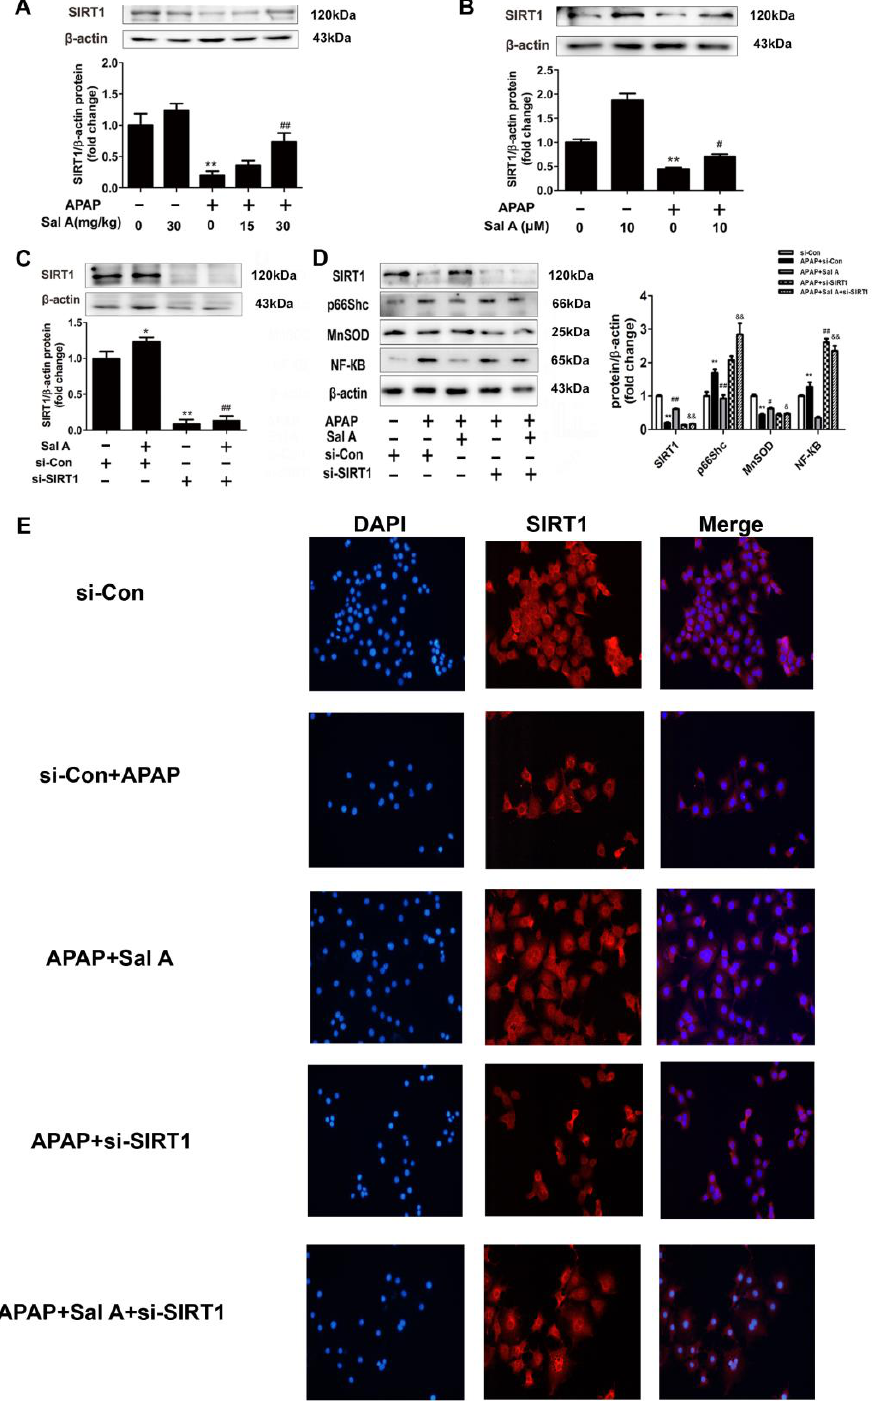
Figure 4. Sal A-mediated protection against APAP involves SIRT1 activation. ( A ) Sal A pretreatment was performed for 3 days followed by APAP stimulation in mice. SIRT1 protein expression in the liver, n = 3. ( B ) AML12 cells were incubated with Sal A before exposure to APAP. SIRT1 protein expression in AML12 cells, n = 3. ( C ) AML12 cells were transfected with control siRNA or SIRT1 siRNA for 24 h and then incubated with Sal A (10 µM) for 6 h. SIRT1 expression in AML12 cells, n = 3. ( D ) AML12 cells were transfected with SIRT1 siRNA or negative control and then incubated with Sal A and APAP. SIRT1, p66Shc, MnSOD and NF-κB protein expressions in AML12 cells, n = 3. ( E )